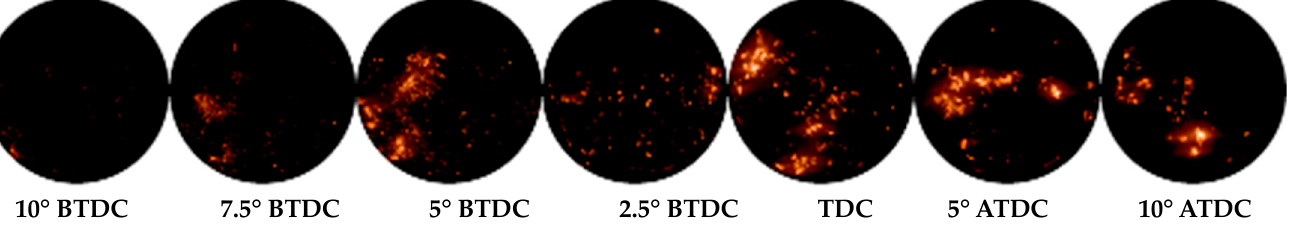
Figure 2. Histories of in-cylinder pressures, rates of heat release, and drive injector current at 2000 rpm and varying injection pressure, with four injections strategy (intake pressure fixed at 2.4 bar).